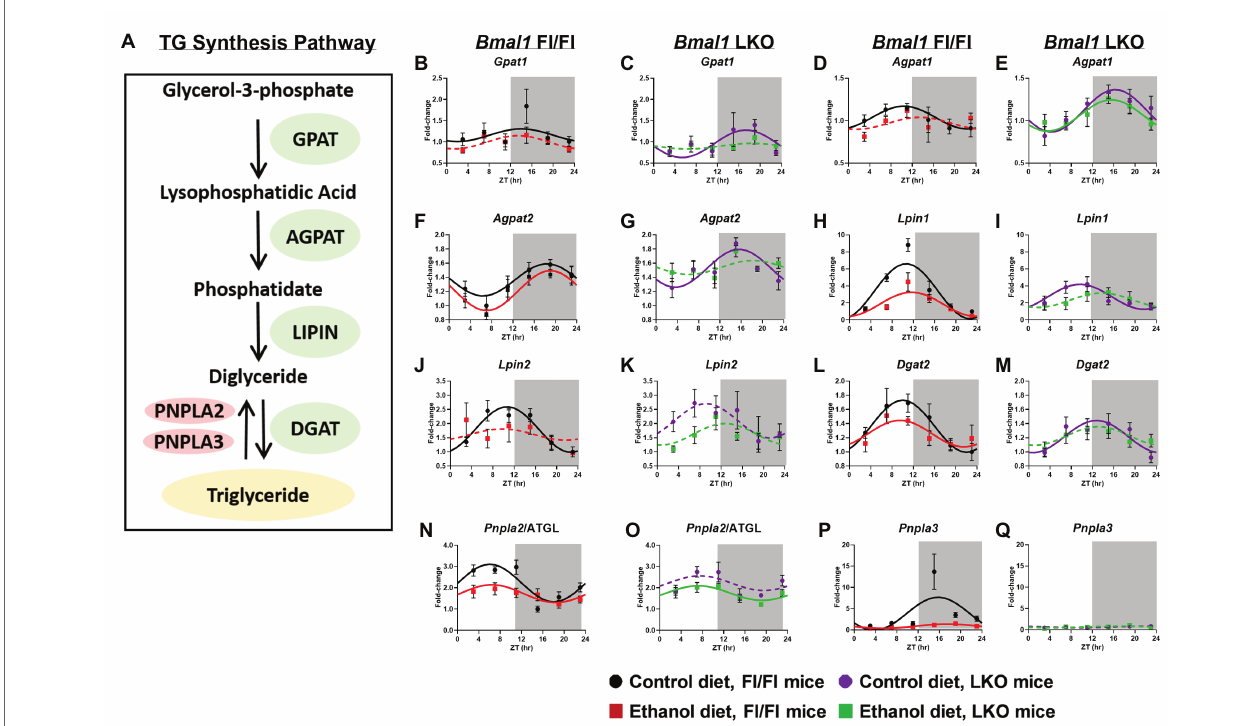
FIGURE 7 | Chronic alcohol and liver clock disruption alter diurnal mRNA rhythms of triglyceride metabolism genes. Pathway for triglyceride synthesis/breakdown (A) . Diurnal mRNA profiles of Glycerol-3-phosphate acyltransferase ( Gpat1 ; B,C ), 1-acyl-sn-glycerol-3-phosphate acyltransferase alpha ( Agpat1 ; D,E ), 1-acyl-sn- glycerol-3-phosphate acyltransferase beta ( Agpat2 ; F,G ), Lipin-1 ( Lpin1 ; H,I ), Lipin-2 ( Lpin2 ; J,K ), Diacylglycerol o-acyltransferase 2 ( Dgat2 ; L,M ), Patatin-like phospholipase domain-containing protein 2/Adipose Triglyceride Lipase ( Pnpla2 /ATGL; N,O ), Patatin-like phospholipase domain-containing protein 3 ( Pnpla3 ; P,Q ) were measured in livers of control-fed (black) and alcohol-fed (red) Bmal1 Flox/Flox (Fl/Fl) and control-fed (purple) and alcohol-fed (green) Bmal1 liver-specific knockout (LKO) mice at ZT 3, 7, 11, 15, 19, and 23 (ZT 0: lights on/inactive period, ZT 12: lights off/active period, gray area) by RT-PCR. Data are presented as a fold-change to the Bmal1 Fl/Fl control diet trough time-point and normalized to Ppia . Data are expressed as mean ± SEM for n = 4–8 mice/genotype/diet/time point. Solid lines indicate rhythmic mRNA levels and a significant cosine fit, whereas dashed lines indicate arrhythmicity and a non-significant cosine fit. Results for Cosinor and ANOVA analyses are provided in Supplementary Tables 4 and 6 ,